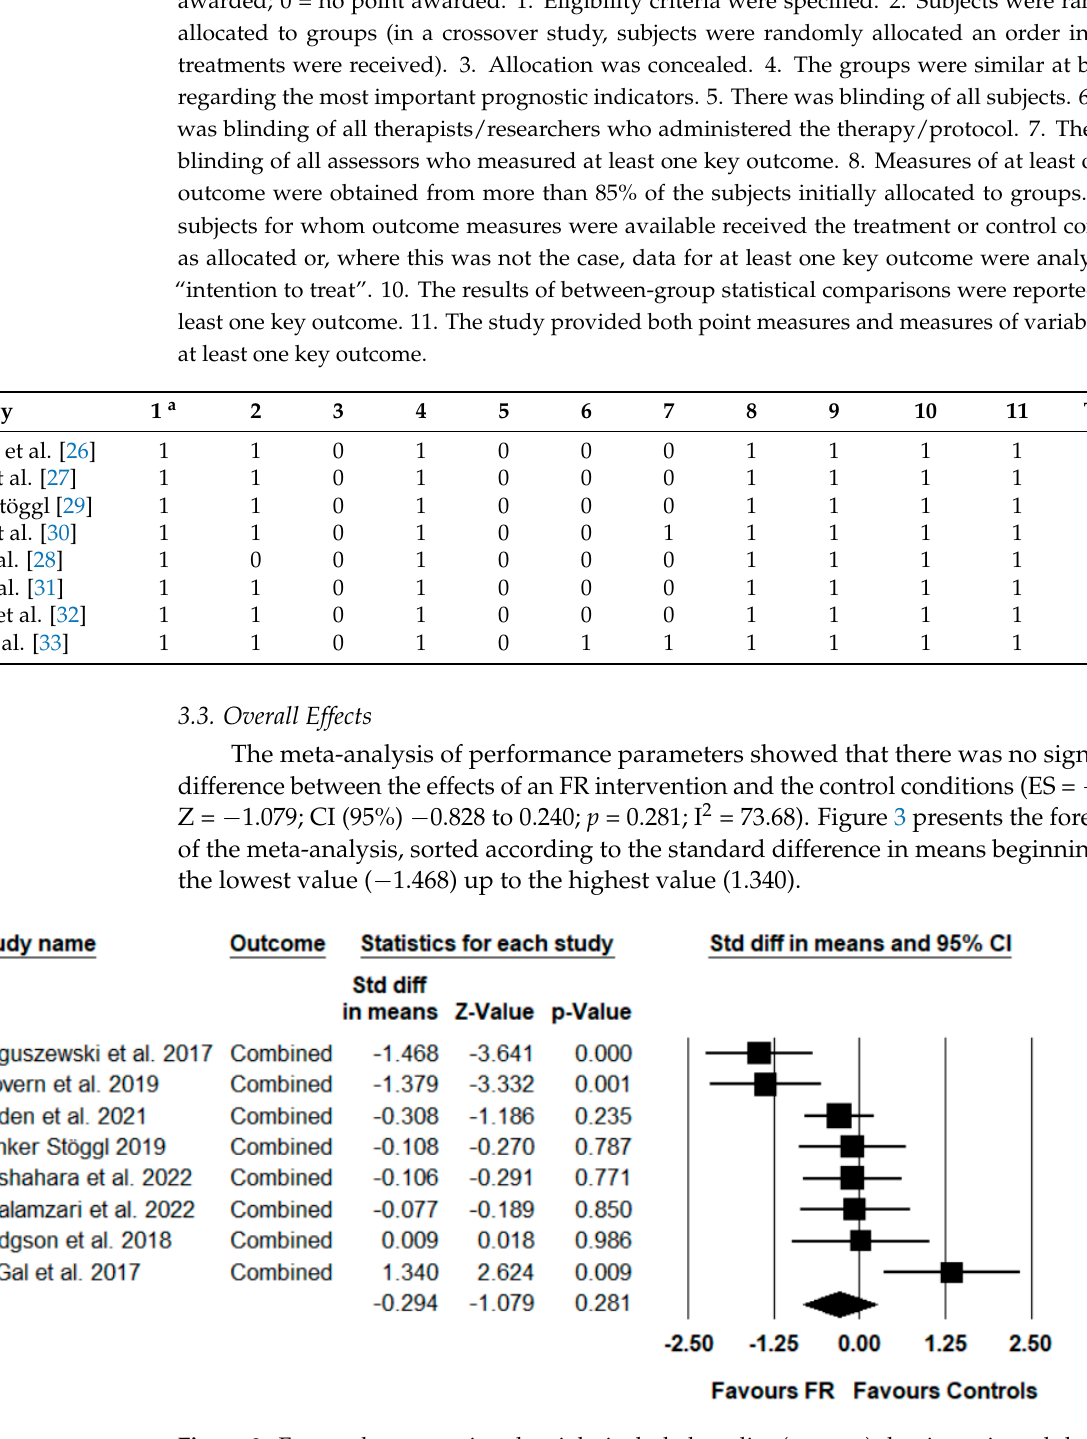
(RCT vs. CT) according to the Q-Statistics (Q = 0.183; df = 1; p = 0.67) (see Figure